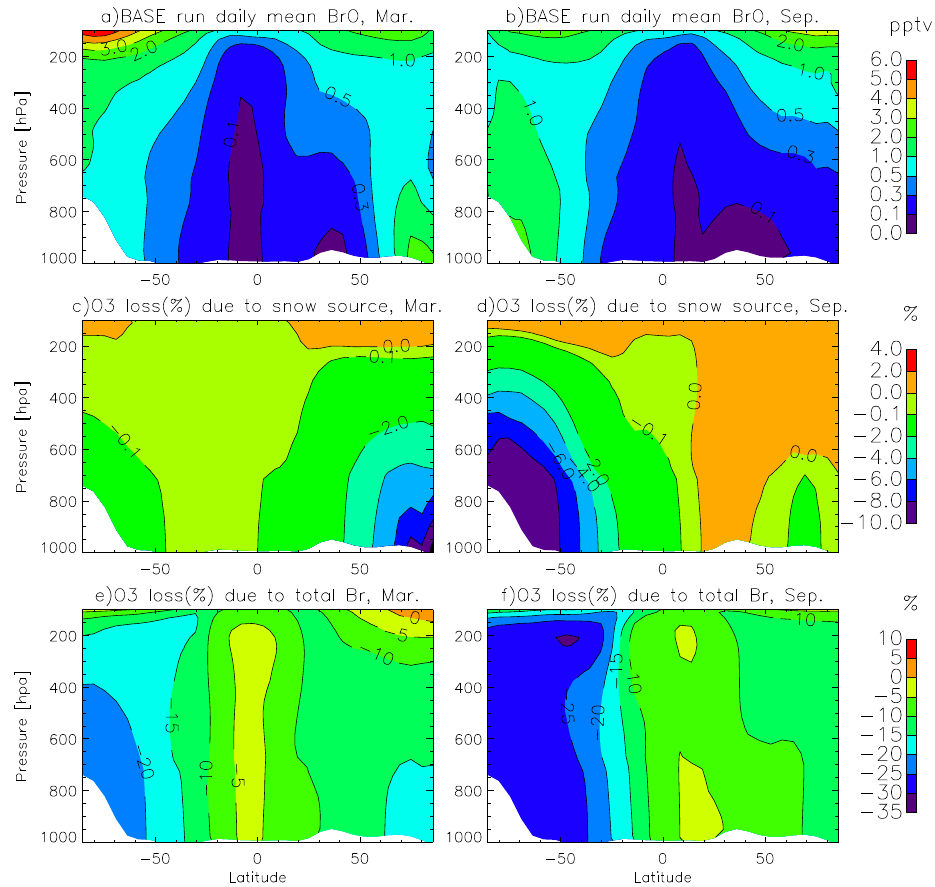
Fig. 5. Zonal mean fields of BrO and ozone loss due to bromine chemistry. Zonal daily averaged BrO (pptv) in (a) March and (b) September of 1998, from BASE run, with plotted interval of 1pptv at BrO > 1 pptv. The calculated ozone reductions (%) due to bromine explosion (snow source) are show in (c) and (d) (calculated according to formula: (BASE run – OCEAN run)/(BASE run) × 100%) with interval of 2% at ozone loss > − 2%. The ozone reductions due to all bromine sources are shown in (e) and (f) by comparing BASE run with noBr run (calculated according to formula (BASE run – noBr run)/(noBr run) ×